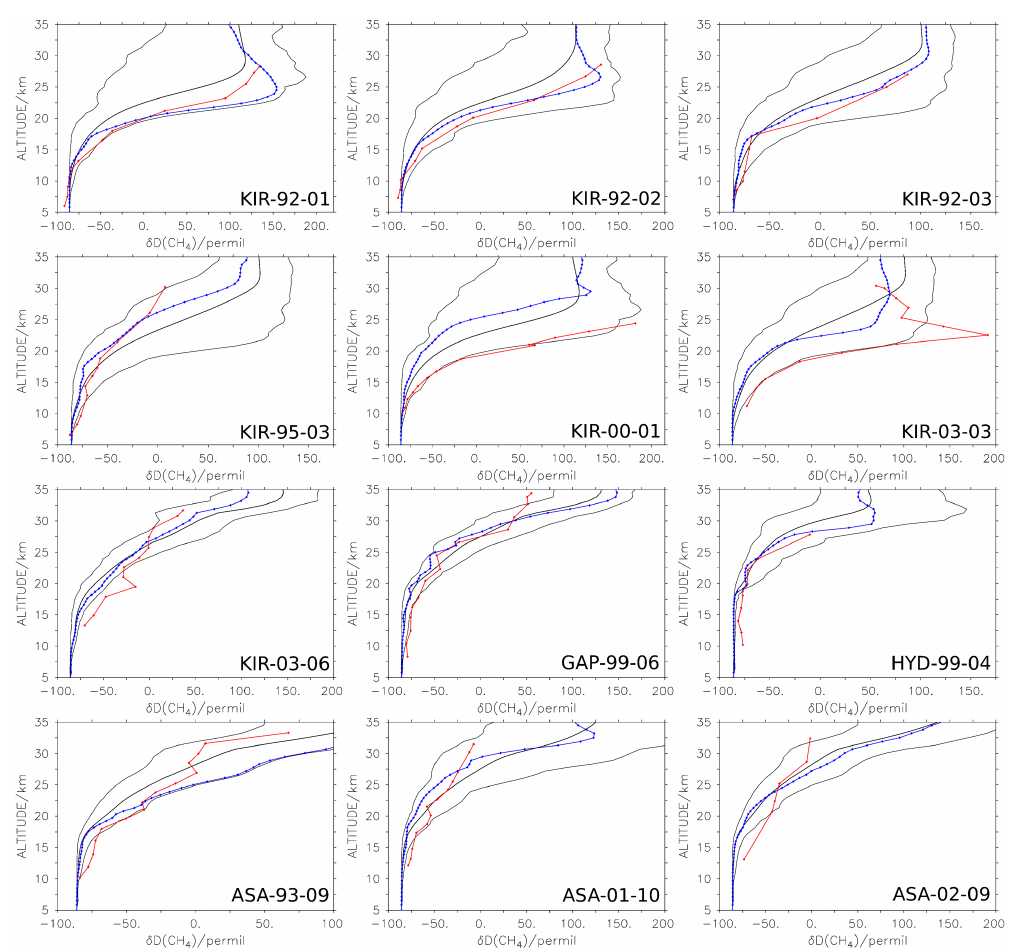
Figure 2. Comparison of δ D(CH 4 ) vertical profiles between EMAC and balloon-borne data by Röckmann et al. (2011). The red lines show the observations and the blue lines show the EMAC data of the same day at the location of the balloon launch. The black lines represent the simulated averages, minima and maxima of the 21 monthly averages of the respective month at the location of the balloon launch. The flight IDs included in the panels denote the location, the year and the month of the balloon flight. KIR: Kiruna, Sweden (67.9 ◦ N, 21.10 ◦ E); GAP: Gap, France (44.44 ◦ N, 6.14 ◦ E); HYD: Hyderabad, India (17.5 ◦ N, 78.60 ◦ E); ASA: Aire sur l’Adour, France (43.70 ◦ N, 0.30 ◦